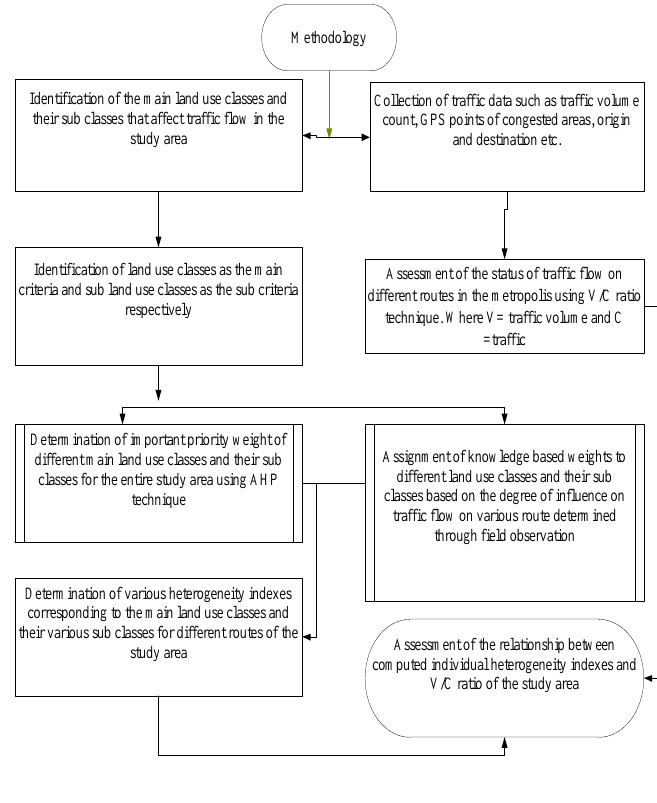
Figure 3: Methodological Design (Adopted after: Alok et al.,